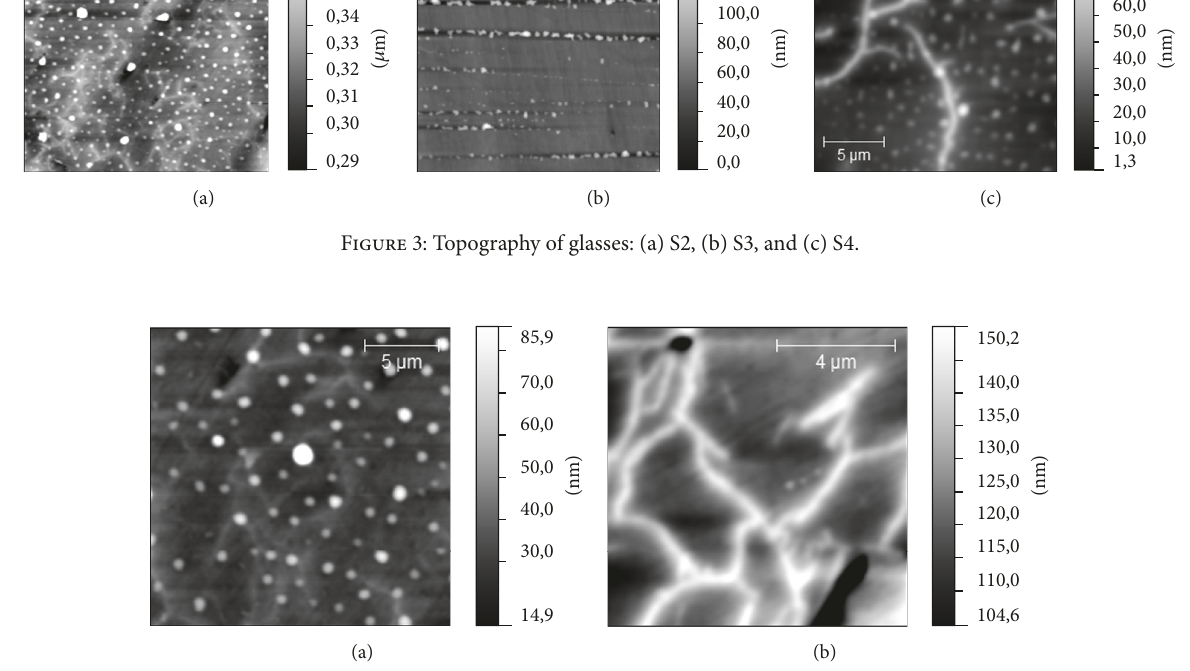
Figure 4: Topography of S2 sample: (a) drop-like surface structure; (b) dendrite-like surface